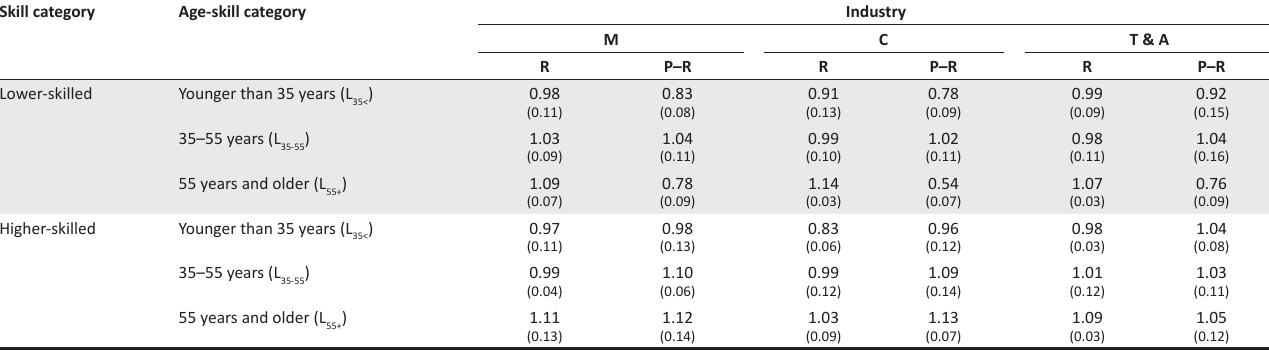
TABLE 3: Employee remuneration and the productivity contribution–employee remuneration ratios per age-skill category for the three industries. Skill